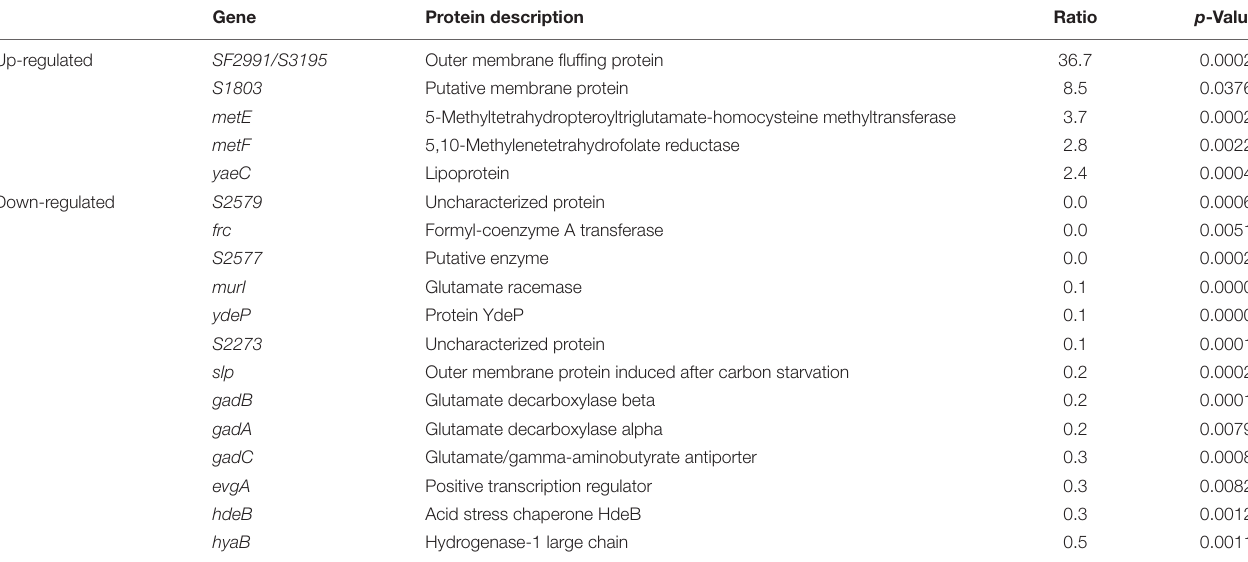
TABLE 1 | A list of altered Shigella proteins in the (cid:49) slyA mutant. Gene Protein description